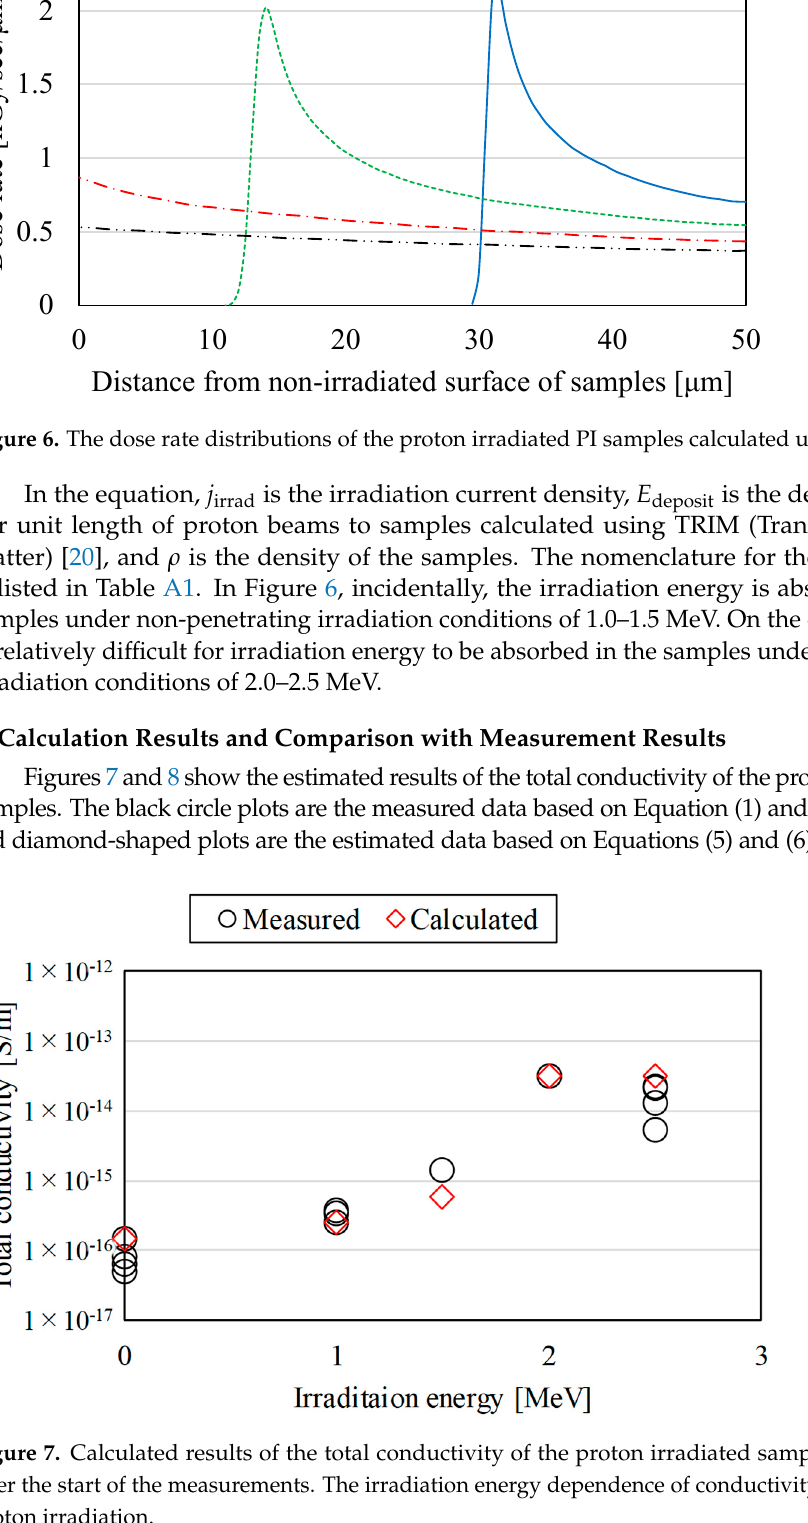
Figure 5. An equivalent circuit of the conductivity of the entire sample irradiated with proton beams.